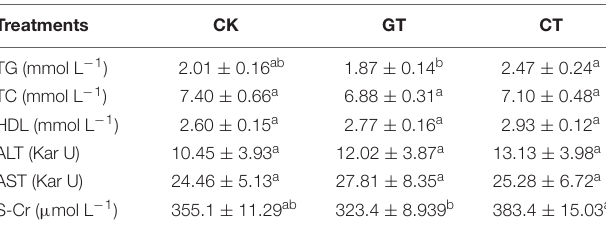
ICR mice drinking C. gloeosporioides- contaminated tea infusion, TABLE 2 | Biochemical levels of ICR